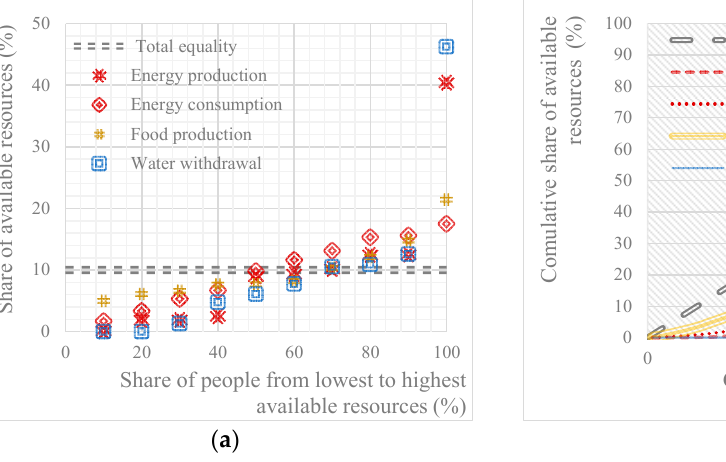
Figure 10. Inequalities of resource distribution per capita. Grey double dash line shows total equality with Gini coefficient equal to 0 (2019); ( a ) Share of resources; ( b ) Lorenz curve.